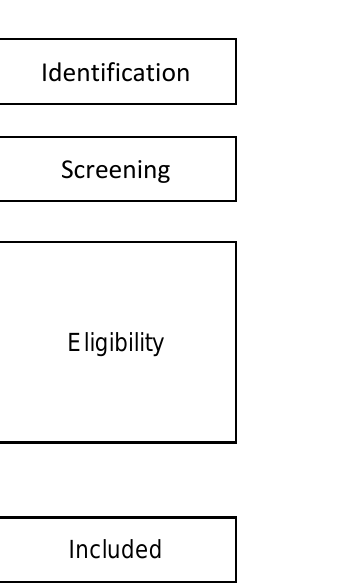
Figure 2. Detailed Literature Review